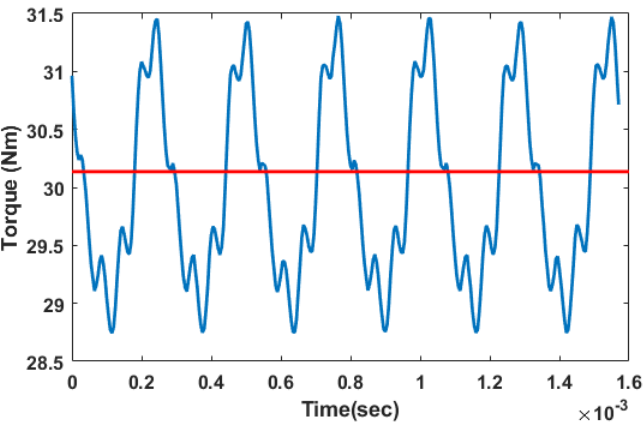
Figure 11. Output torque of the optimum motor.